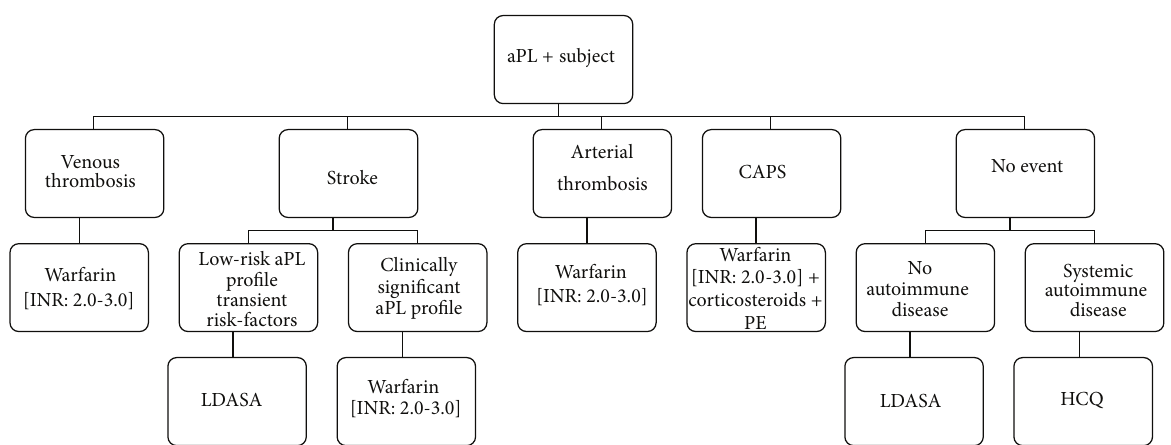
Figure 2: Flow-diagram of the therapeutic approach to thrombotic APS. aPL: antiphospholipid antibodies; CAPS: catastrophic antiphospho- lipid syndrome; LDASA: low-dose aspirin; PE: plasma exchange; HCQ: